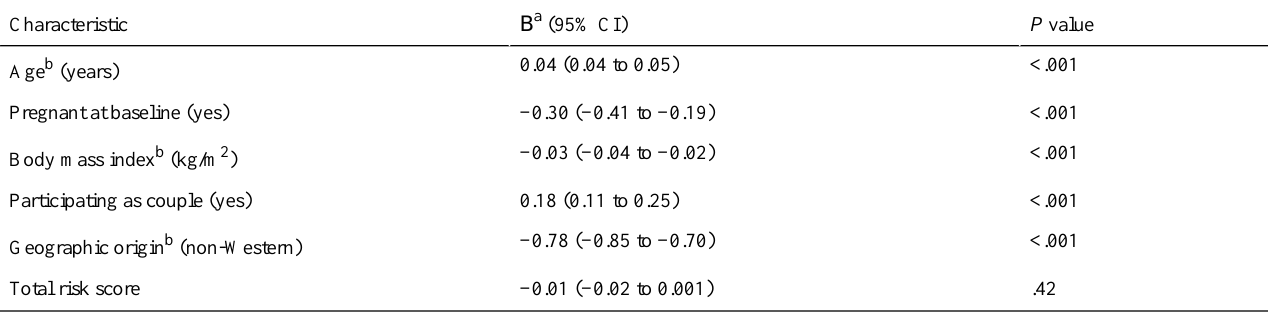
Table 2. Univariate associations between the neighborhood status score and demographic factors